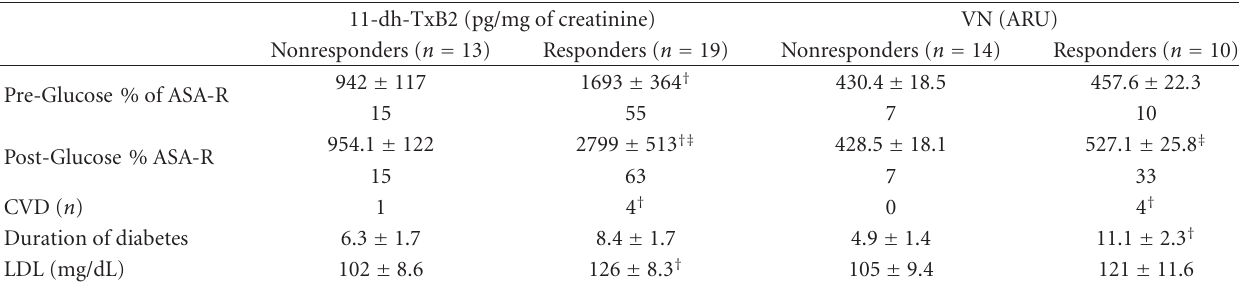
Table 3: Response to glucose